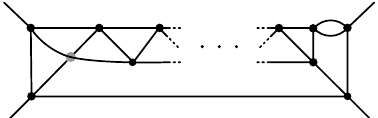
Figure 26: Asymmetric variation of the triangle chain represented in figure 4. It is obtained by expanding into a bubble one of the vertices connecting to an external leg. This variation exists for both planar and non-planar iterations (represented by the gray vertex). For the first three iterations one can prove analytically that such graphs are trivial. For the fourth iteration, no solution was found in 1000 attempts. For the succeeding iterations we do not have a numerical argument for the absence of α -positive solution.